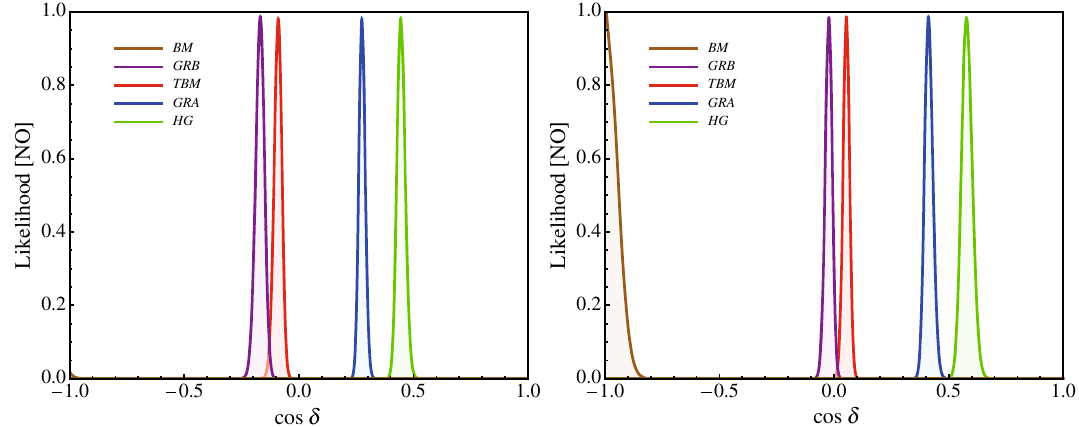
Table 4 Best fit values of J CP and cos δ and corresponding 3 σ ranges (found fixing χ 2 − χ 2 = 9) for the five min symmetry forms, TBM, BM, GRA, GRB and HG, and ˜ U e given by the form A0 in Eq. (67) obtained using the data from [56] for NO neutrino mass spectrum. (From Refs. [39,40], where results for IO spectrum are also given.)